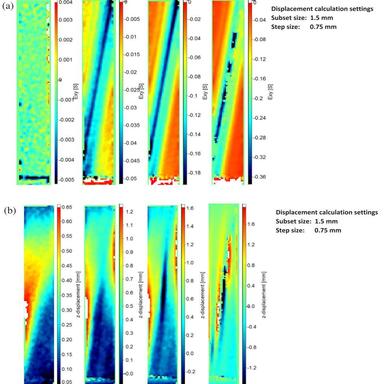
DIC analysis results – (a) Shear strain field and (b) Out of plane deformation for an IM7/8552 specimen of 3 plies thickness, 8 mm wide shear band tested at 0.01/s. (For interpretation of the references to colour in this figure legend, the reader is referred to the web version of this article.)